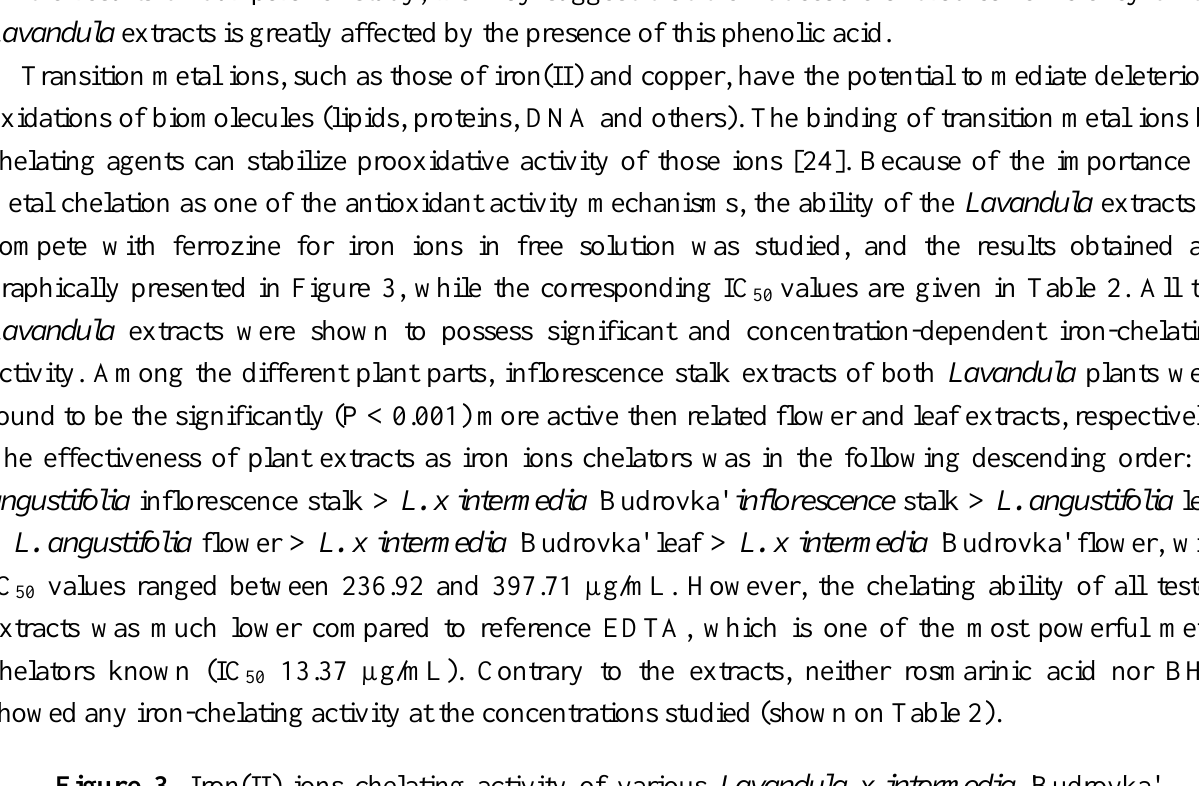
Figure 3. Iron(II) ions chelating activity of various Lavandula x intermedia 'Budrovka' (LiB) and L. angustifolia (La) extracts at different concentrations. EDTA was used as